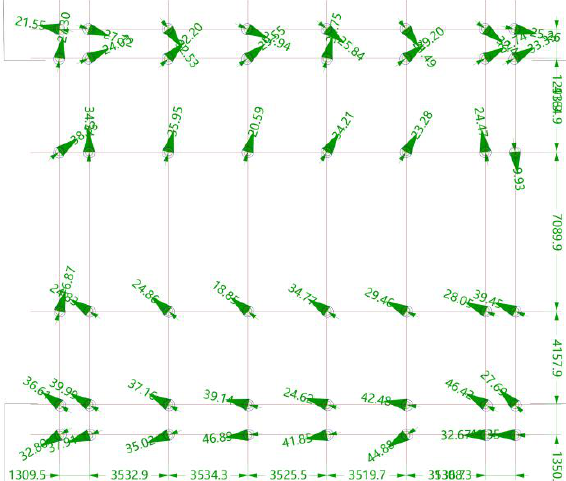
Figure 4. Deviation between the measurements and the results of rebuilding for the column